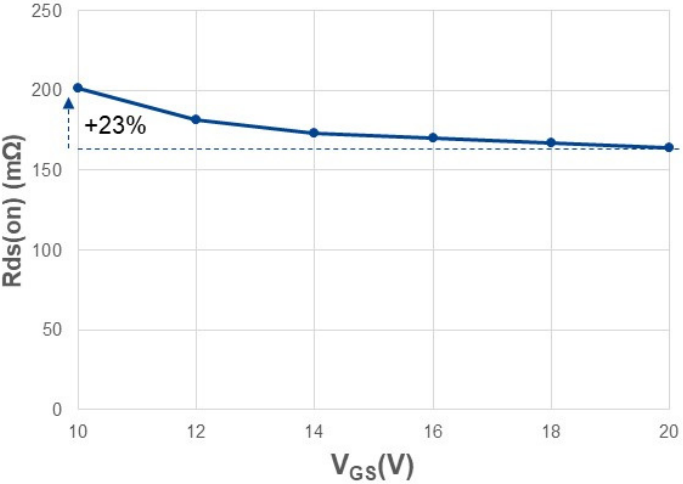
Figure 12. R DSon (V GS ) under V Drv depolarization @I D = 20 A, T CASE = 200 ◦ C from Data-Sheet device SCTW40N120G2VAG; https://www.st.com (accessed on 25 November 2021)